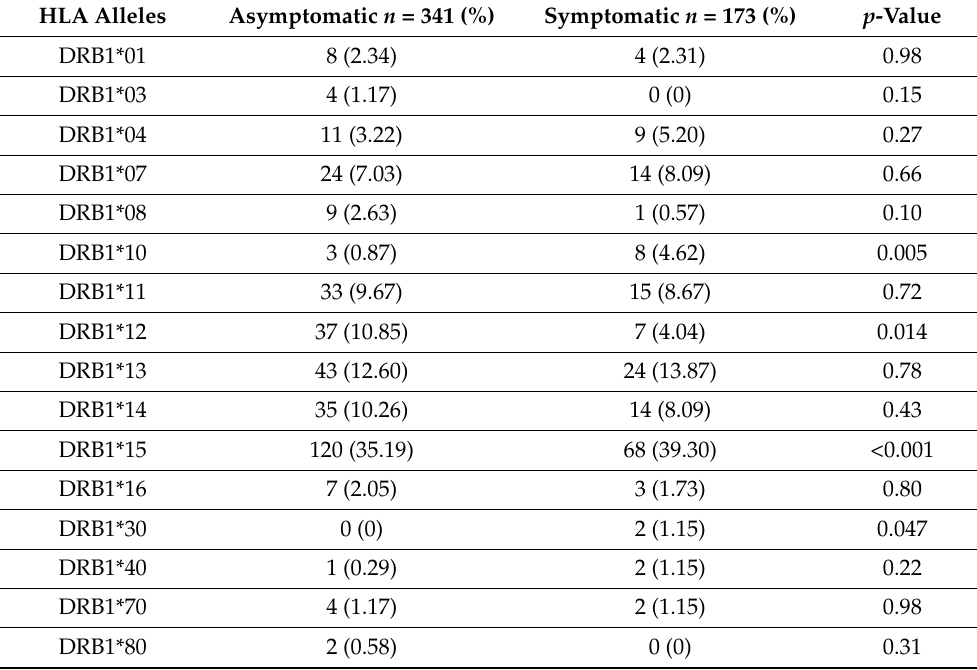
Table 3. HLA-DRB1 alleles frequency in RTRs with asymptomatic and symptomatic